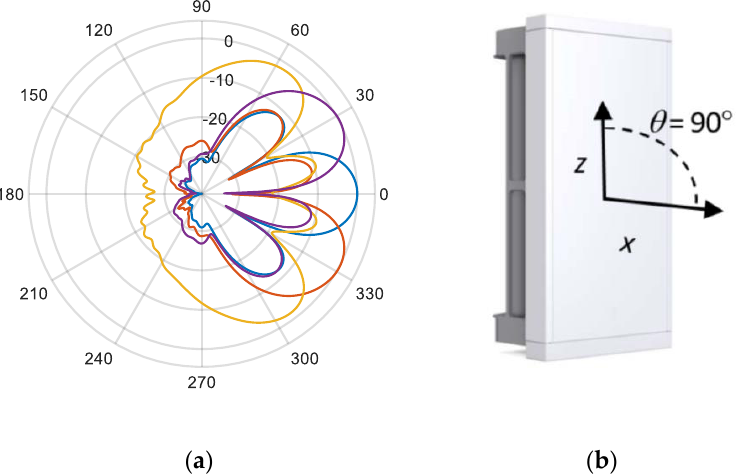
Figure 2. ( a ) Antenna radiation patterns for four beam configurations (in different colors) in the azimuth plane ( 𝜃 = 90° ). The values in the polar plot are normalized to the peak gain of the broadside beam and presented in a logarithmic scale in dB. Only a subset of the available BS beams is shown. ( b ) Reference system with respect to the antenna.